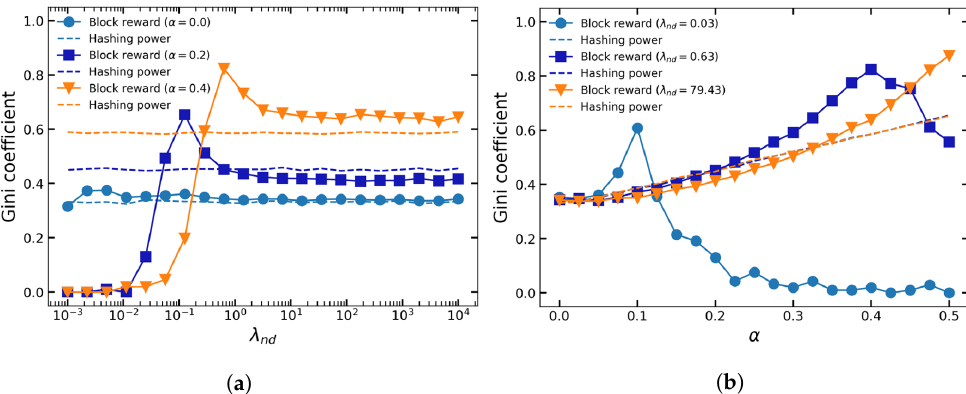
Figure 8. Gini coefficients as a function of: ( a ) latency ( λ nd ) and ( b ) selfish hashing power ( α